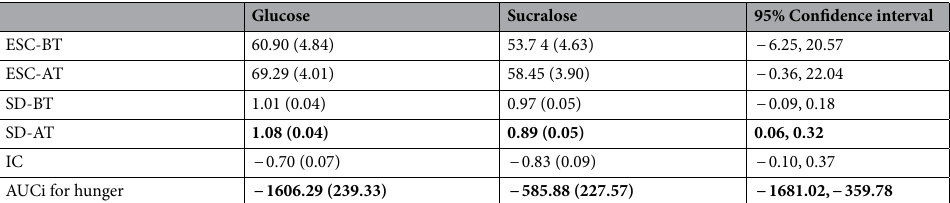
Table 2. Mean difference (se) between the interoceptive indices in the glucose and sucralose conditions. N = 62. IC interoceptive coherence, SD satiety divergence, ESC expected satiety confidence, BT before tasting, AT after tasting, AUCi area under the curve with respect to ground. Bold—significantly